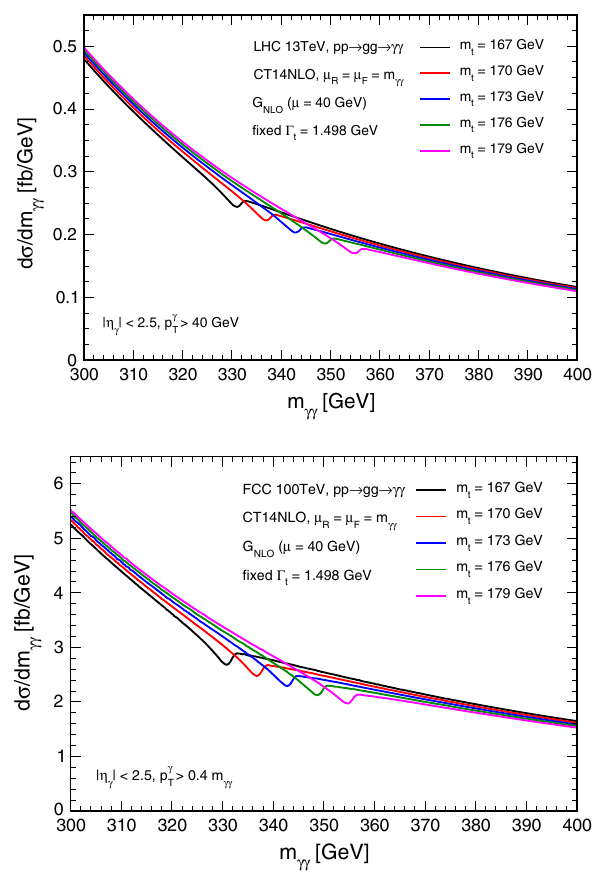
Fig. 4 gg → γγ contribution to the diphoton invariant-mass distri- bution for different m t . Top panel is for the LHC 13 TeV and bottom panel is for the FCC 100 TeV